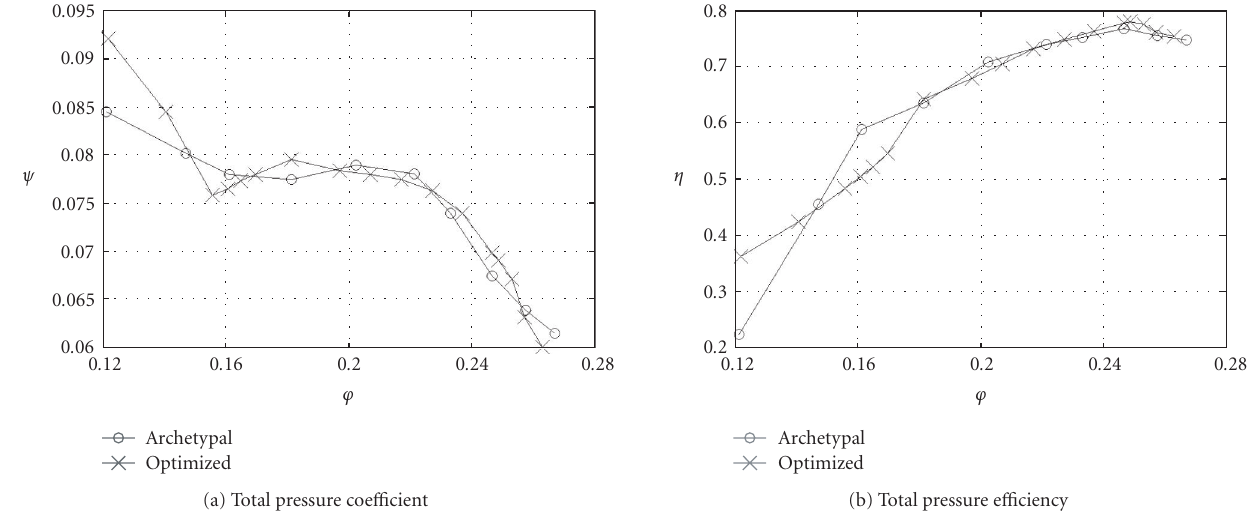
Figure 10: Aerodynamic performance curves.